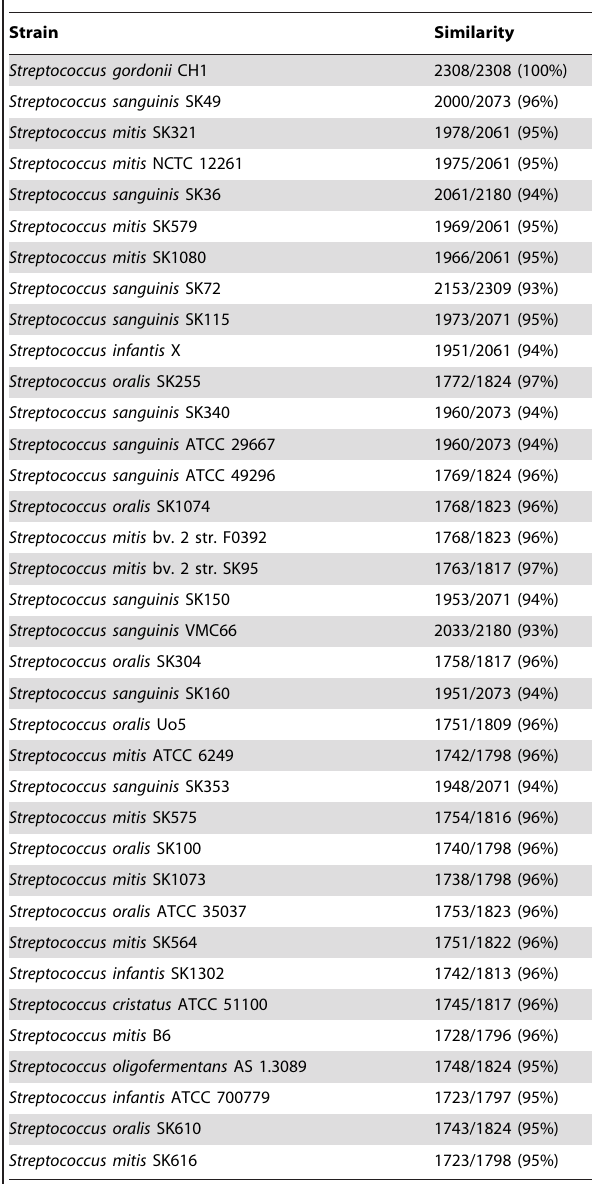
Table 2. Distribution of spxB among oral